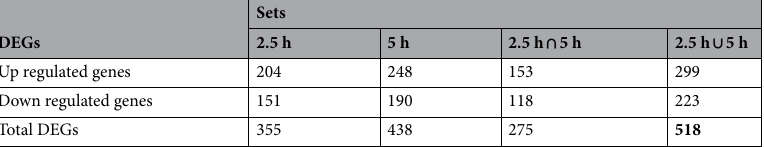
Table 1. Comparison of DEGs of PaeAG1 at 2.5 and 5 h after treatment with Ciprofloxacin, including counts of down or up regulated genes, shared genes (intersection) and total genes at both times (union).